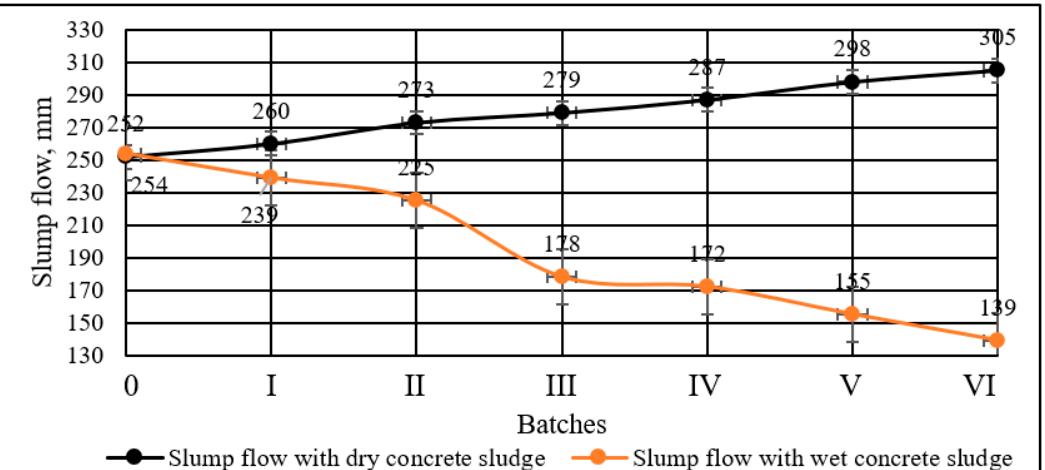
Figure 5. Slump flow of cement paste with different amounts of cement replaced with wet and dry concrete sludge.